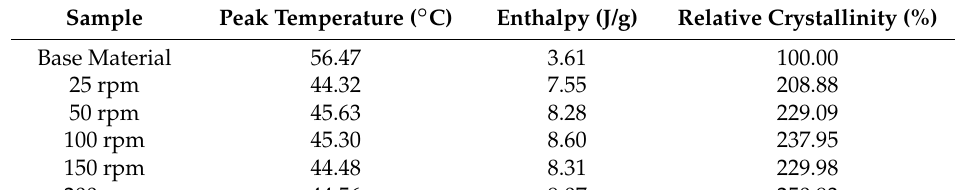
Figure 3. Overlay differential scanning calometry (DSC) thermogram of samples from each process run number. Table 3. Effect of various screw speeds on SSB ® 55 Pharma grade Shellac endothermic peak and enthalpy.